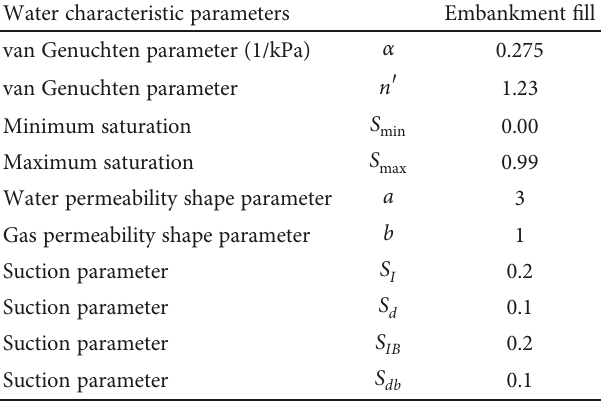
Table 3: Soil-water characteristic curve and hydraulic parameters. Water characteristic parameters